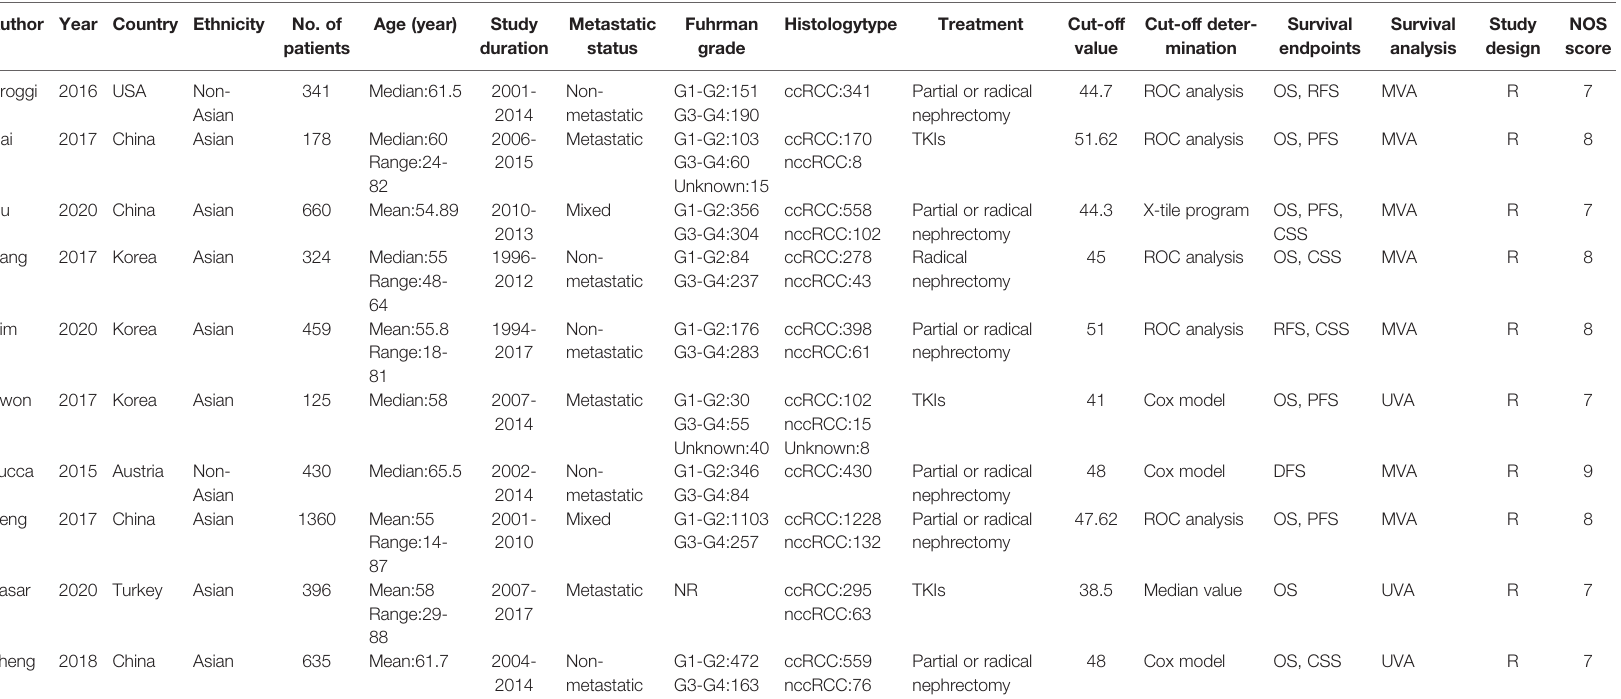
TABLE 1 | Main characteristics of eligible studies in the meta-analysis. Author Year Country